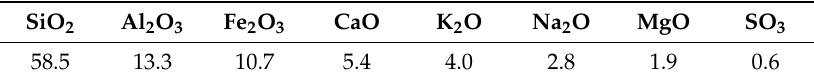
Table 1. Chemical composition (wt %) of copper-mine